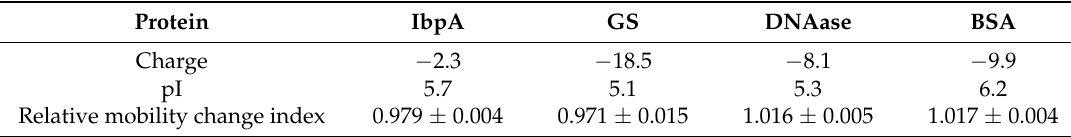
Figure 9. The electrophoretic separation of non-treated and F105 -treated proteins under native conditions. Table 3. Properties of